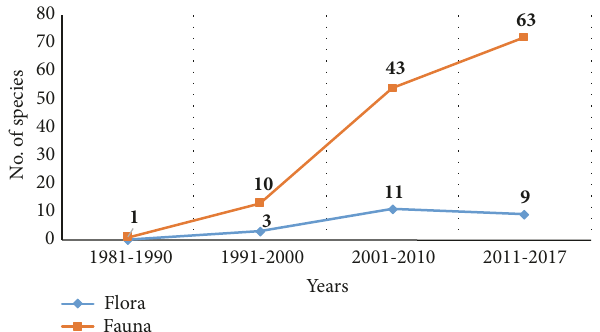
Figure 5: Species discovered in the Far-Eastern Himalayan